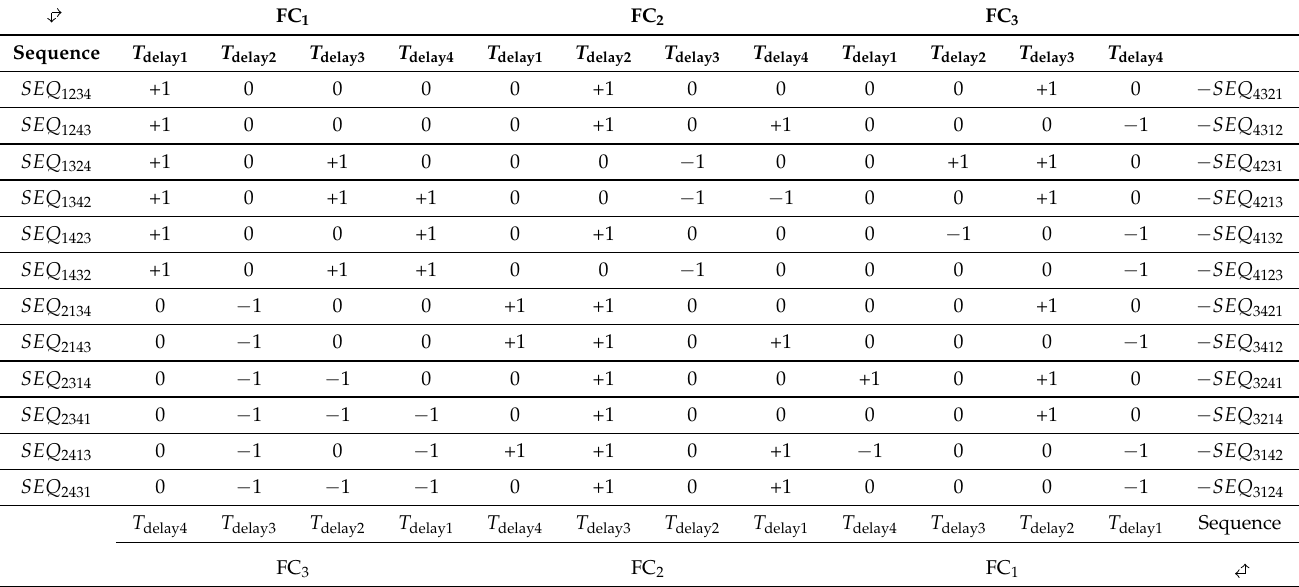
Table 1. Effect of all sequences available ( S CL ) for Q2L-5L-FCC on FC charge increments in the function of delay times for Q2L ZVS transition (for HS transition, the same value but opposite signs apply): (+1) charge, ( − 1) discharge, (0) no effect. Scaling the values with the respective T delay { n } and I o,max gives the charge increment values. Note that the table is simplified and values for SEQ 3xxx and SEQ 4xxx are obtained by using symmetry and multiplying the respective values by ( −